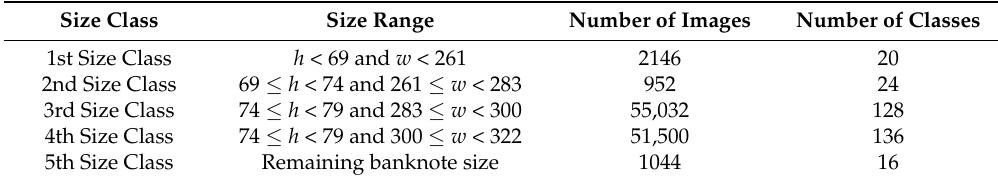
Table 5. Number of banknote classes in each size classes ( h and w stand for height and width in pixel units of segmented banknote images).